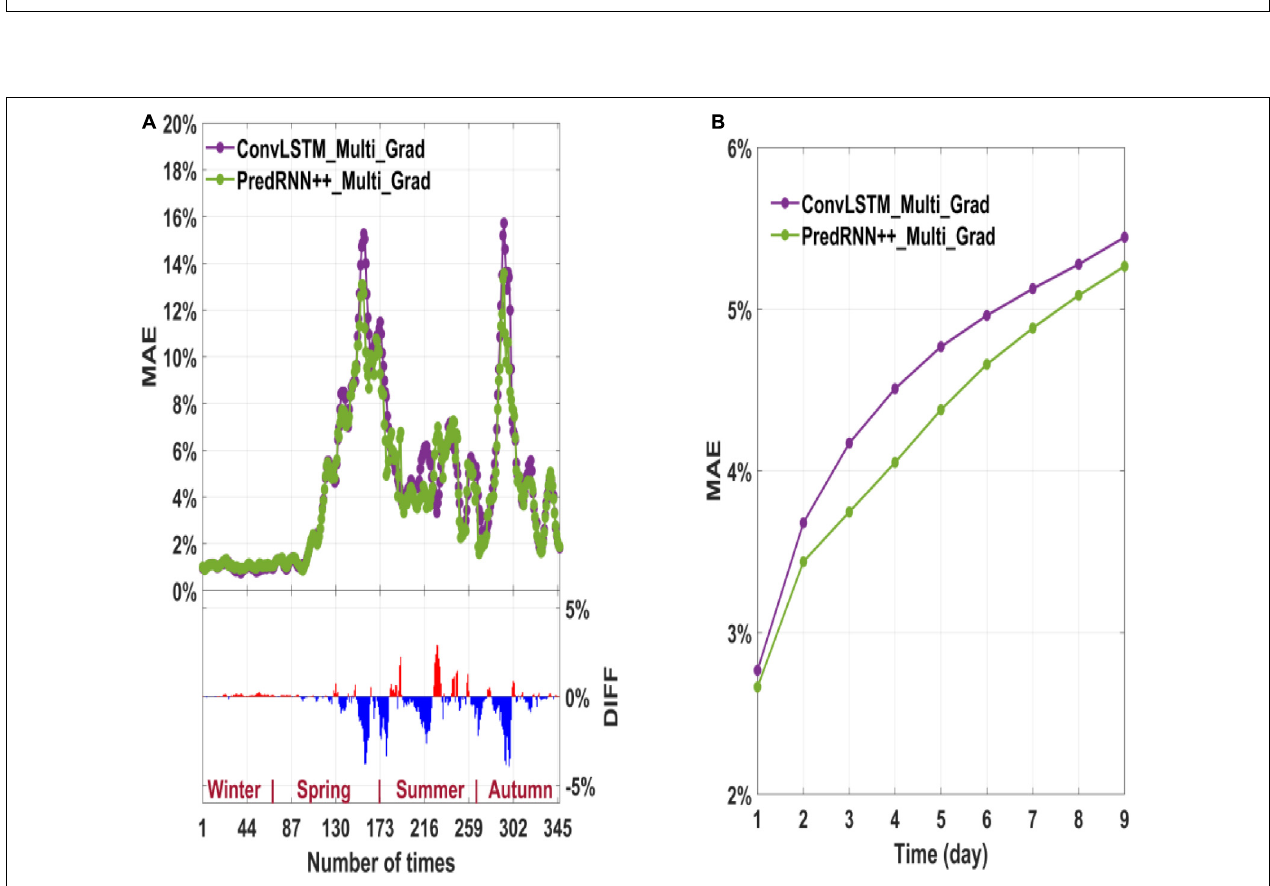
FIGURE 10 | Average MAE of the ConvLSTM and PredRNN++ multi-factor models in 347 predictions (A) ; The average MAE of the nine consecutive days of prediction (B) . The DIFF in the bar graph is obtained by subtracting the model of ConvLSTM from the model of PredRNN++.